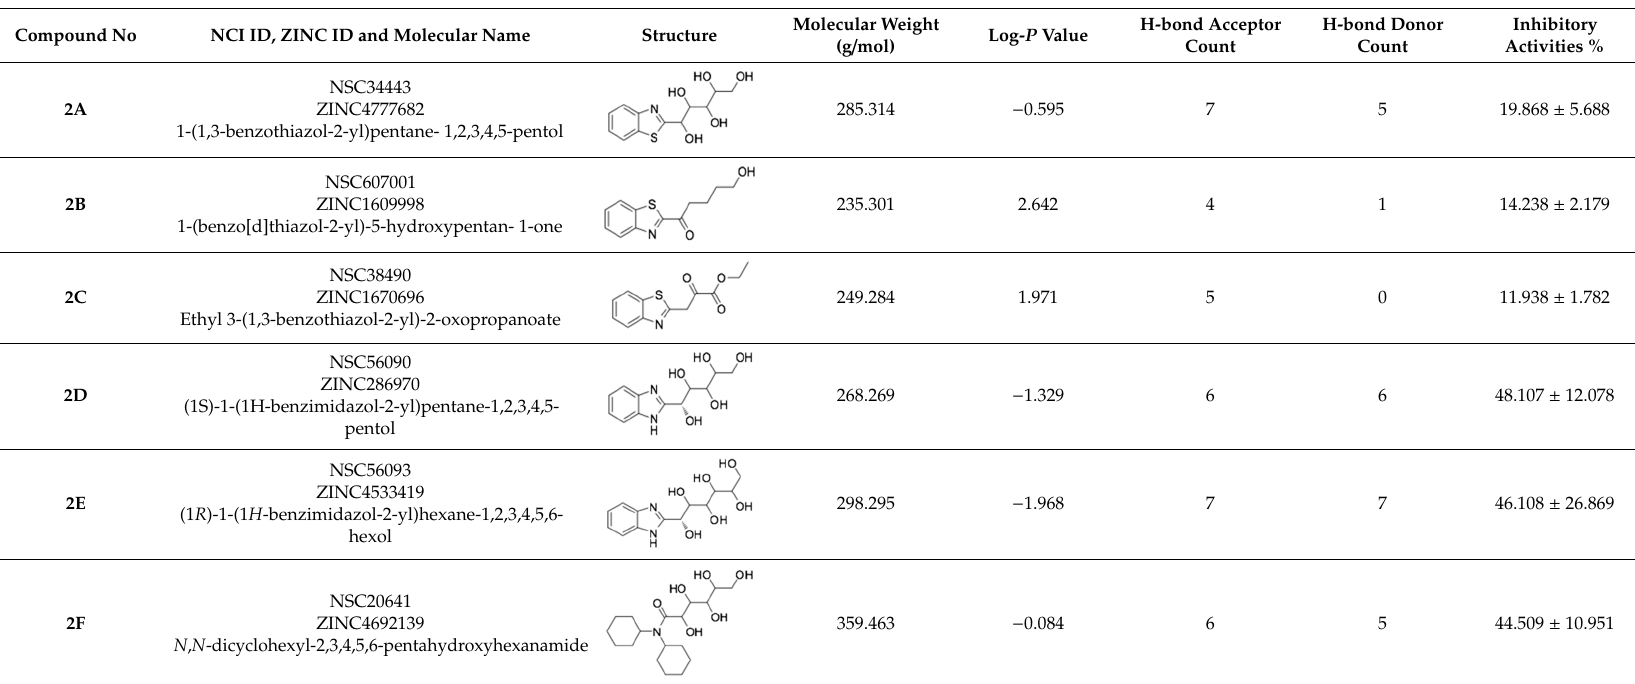
Figure 8. Inhibitory activities of derivative compounds against ZIKV infection on BHK-21 cell lines. ( A ) Inhibitory activities of Compounds 1 and 1A–1F at a concentration of 20 μ M. ( B ) Inhibitory activities of Compounds 2 and 2A–2F at a concentration of 50 μ M. IFN- α at 20 IU served as a positive control.